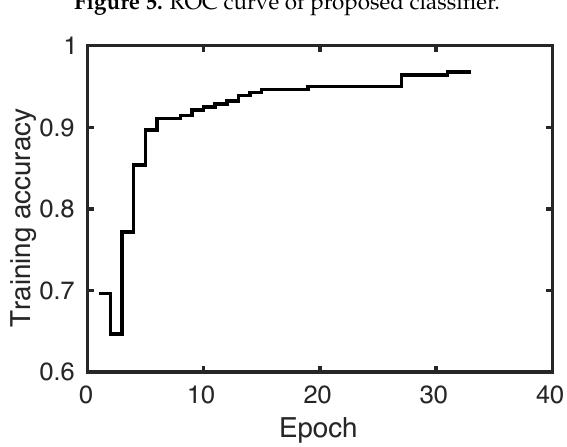
Figure 6. Training accuracy versus iterations.